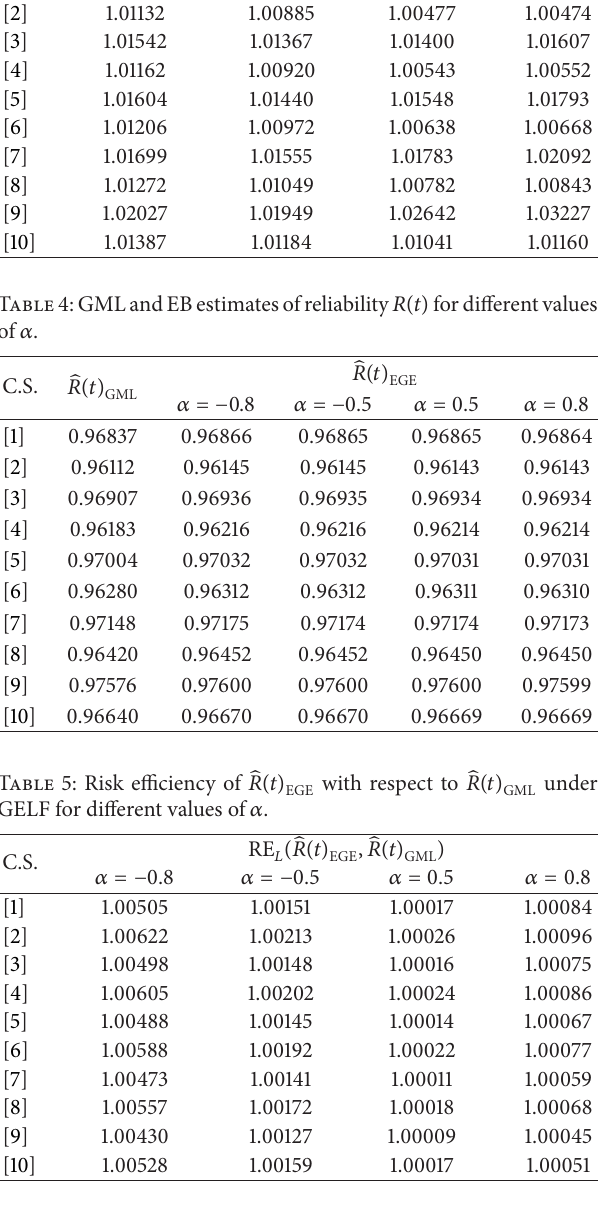
Table 3: Risk efficiency of for different values of 𝛼 .